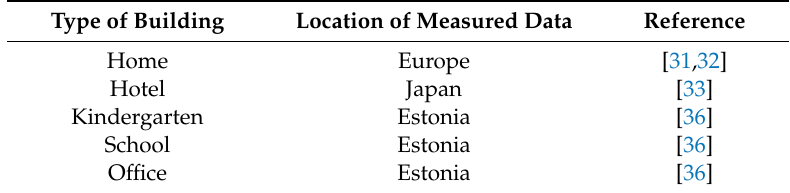
Table 3. Demand data